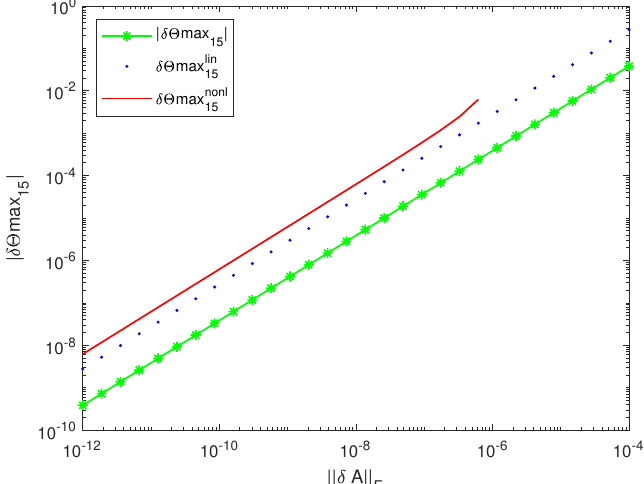
Figure 6. Exact values of δ Θ max 15 and its bounds as functions of the perturbation norm.